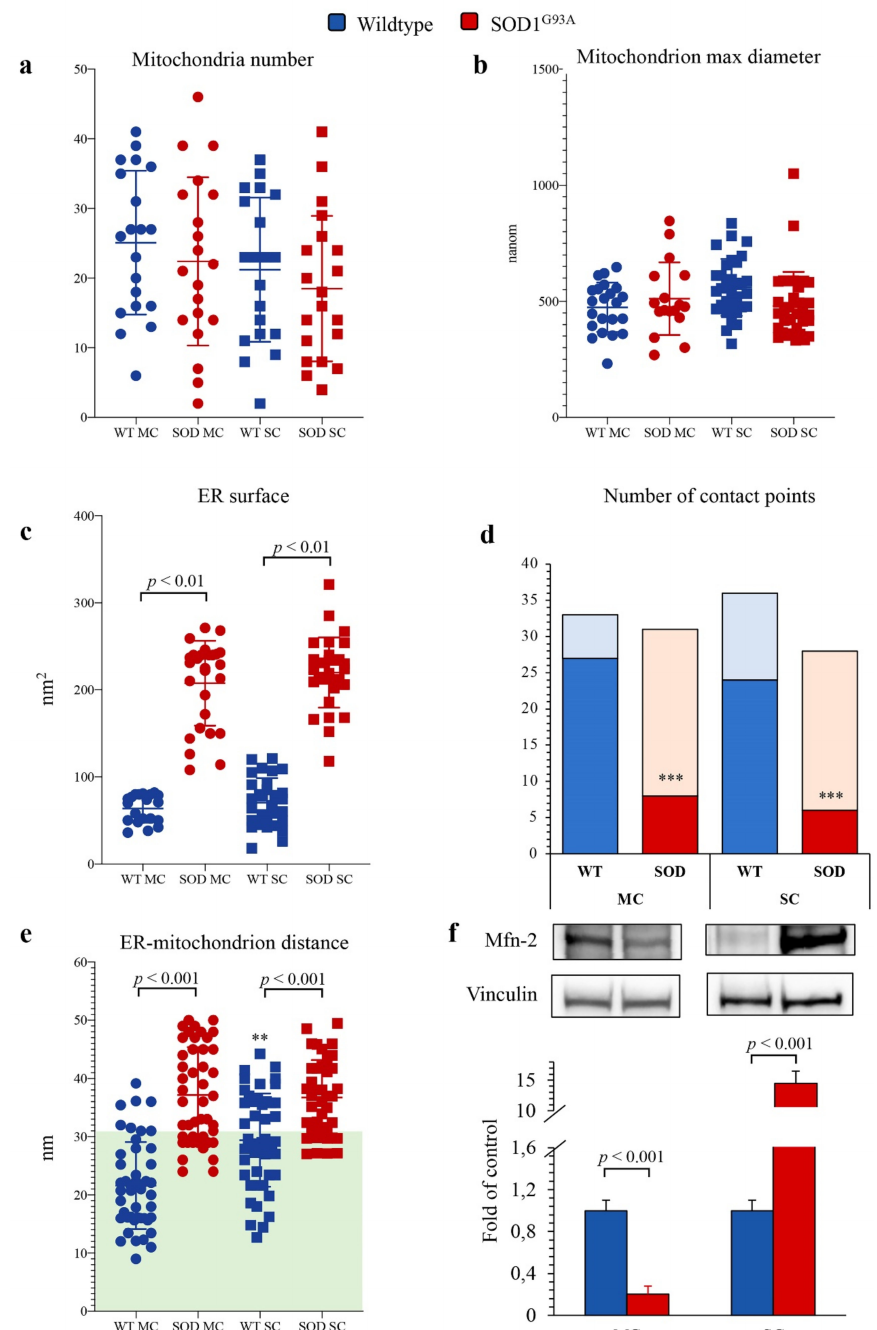
Figure 6. Electron microscopy ultrastructure of ER and mitochondria. Mitochondrial number ( a ), mito- chondria max diameter ( b ), ER surface ( c ) in wildtype (blue) and SOD1 G93A (red) of motor cortex (MC, circles) and spinal cord (SC, squares) astrocytes. Number of contact points ( d ) and distance between ER and mitochondria ( e ) evaluated in MC and SC astrocytes harvested from WT and SOD1 G93A mice (with the green area indicating distance < 30 nm, considered as contact points). Western blot analysis and relative densitometry quantitative analyses of Mfn2 ( f ) in wildtype (blue) and SOD1 G93A (red) astrocytes harvested from MC and SC. Data are shown as the mean ± SD. n = 3 experiments per group, with each value defined in triplicate. ** = p < 0.01, *** = p < 0.001 vs. corresponding MC